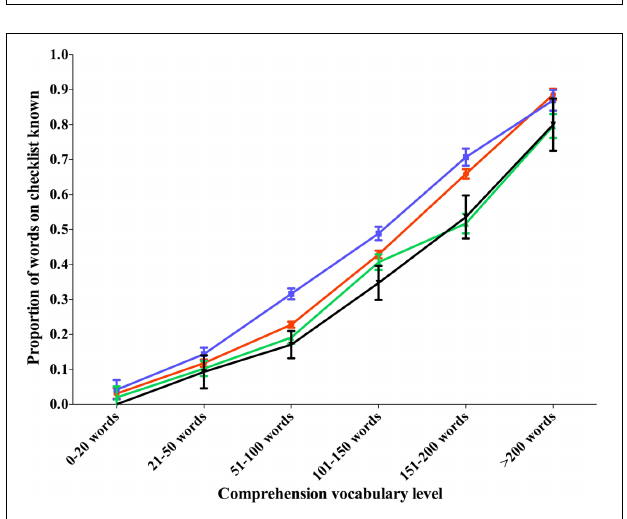
FIGURE 4 | Proportion of words in different categories comprehended by children of different vocabulary